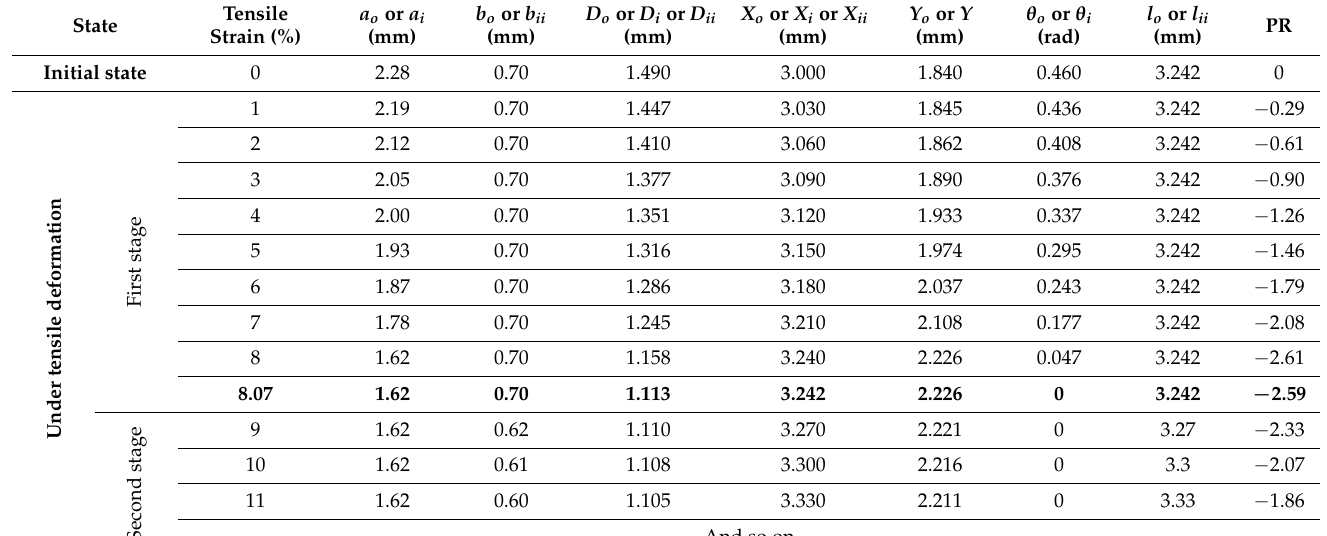
Table 2. Structural parameters and the calculated Poisson’s ratio results of 3D auxetic woven